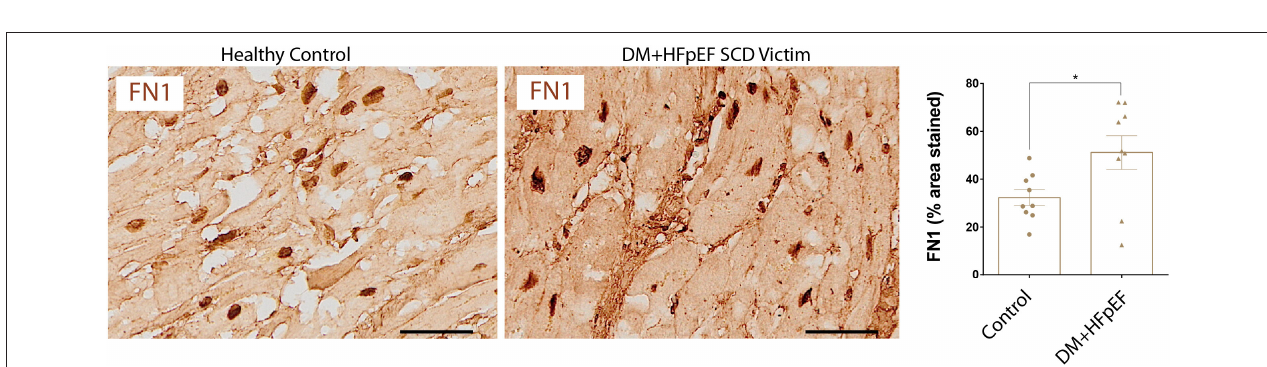
FIGURE 2 | Downregulation of DNM2 in SCD victims with DM + HFpEF. Immunostaining of cardiac biopsies of SCD victims with both HFpEF and DM shows lower DNM2 protein expression compared to control hearts. Data are mean ± SEM. N = 9–10 subjects/group. Scale bar = 50 µ m. HFpEF, Heart Failure with Preserved Ejection Fraction; DM, Diabetes Mellitus; DNM2, Dynamin-2. *** p < 0.001 using Student’s t -test.